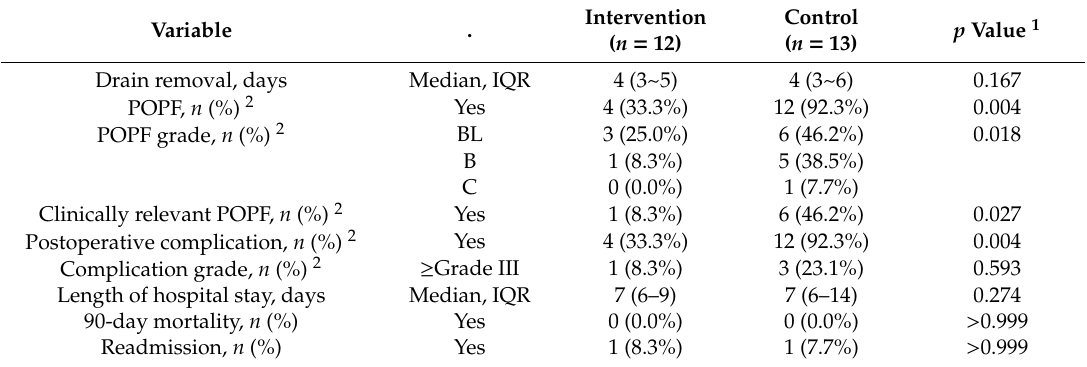
Table 3. Sub-analysis of postoperative pancreatic fistula and morbidities for patients who underwent distal